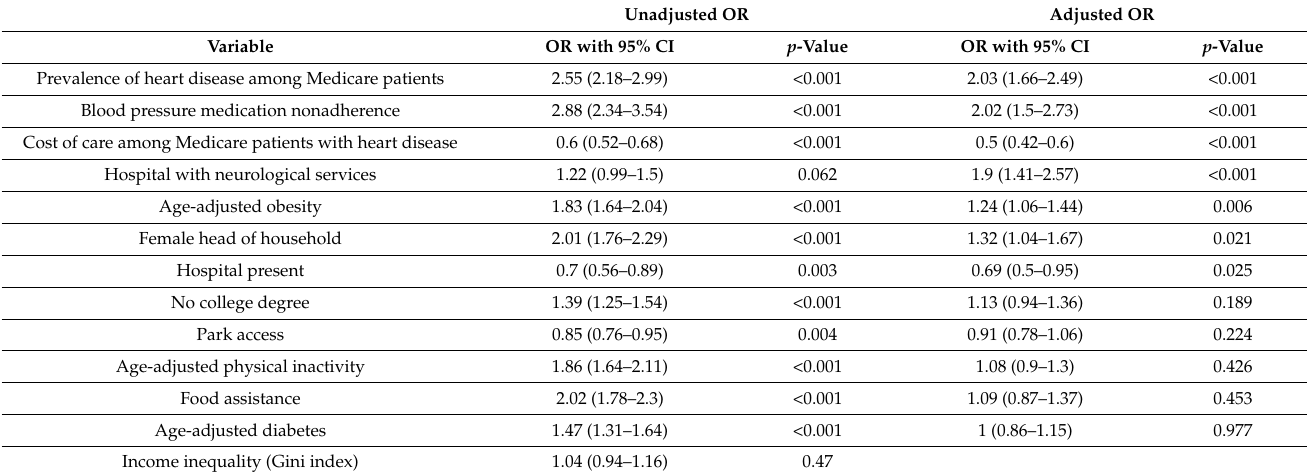
Table 2. Univariate and multivariate binomial generalized linear mixed model analyses for stroke hos- pitalization rate (SHR) per 1000 Medicare beneficiaries, 65+, all races/ethnicities, and both genders. Unadjusted OR Adjusted OR OR with 95% CI p -Value OR with 95% CI p